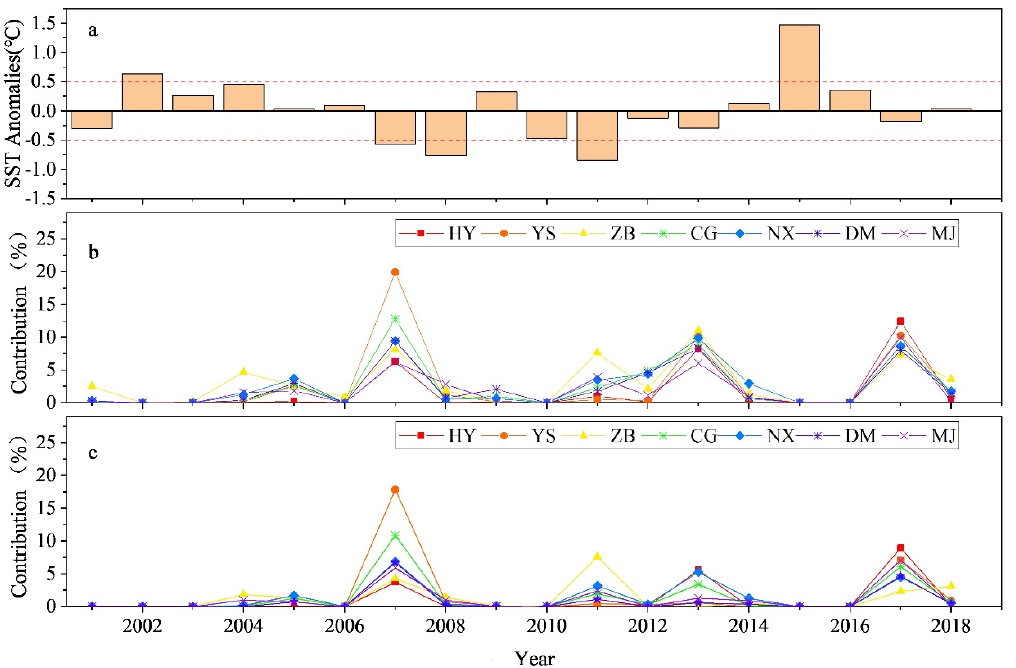
Figure 7. Annual contribution of TCs and SST during 2001–2018. ( a ) SST anomalies (dotted lines are ±0.5 °C); ( b ) annual contribution of TCs during 2001–2018 (when the distance between the tropical cyclone center and island is 800 km); ( c ) annual contribution of TCs during 2001–2018 (when the distance between the tropical cyclone center and island is 500 km).